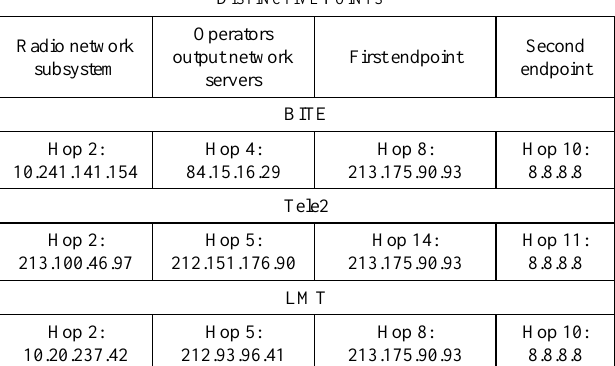
D ISTINCTIVE P OINTS